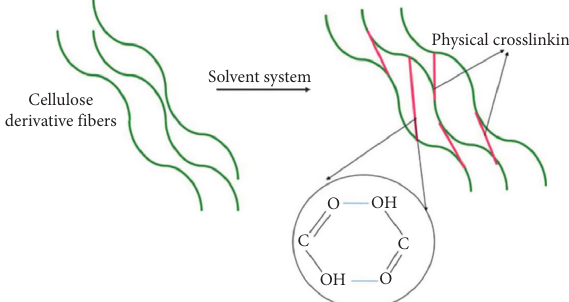
Figure 6: Schematic representation of physical hydrogels synthesis technique (adapted from